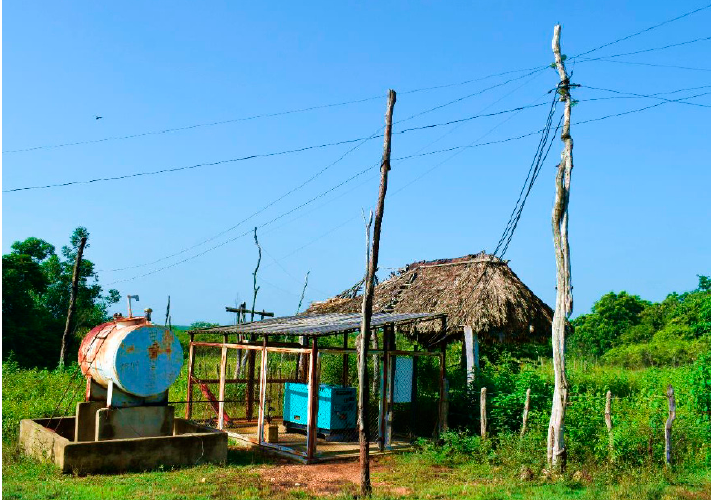
Figure 3. Generator set of 20 kVA (16 kW) and fuel storage tank in